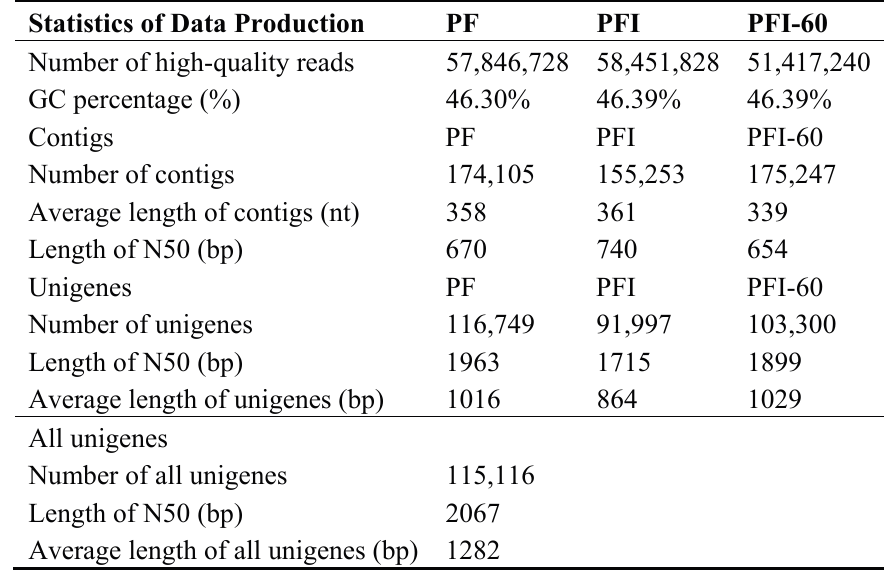
Table 1. Overview of the sequencing and assembly of the transcriptome of P. fortunei